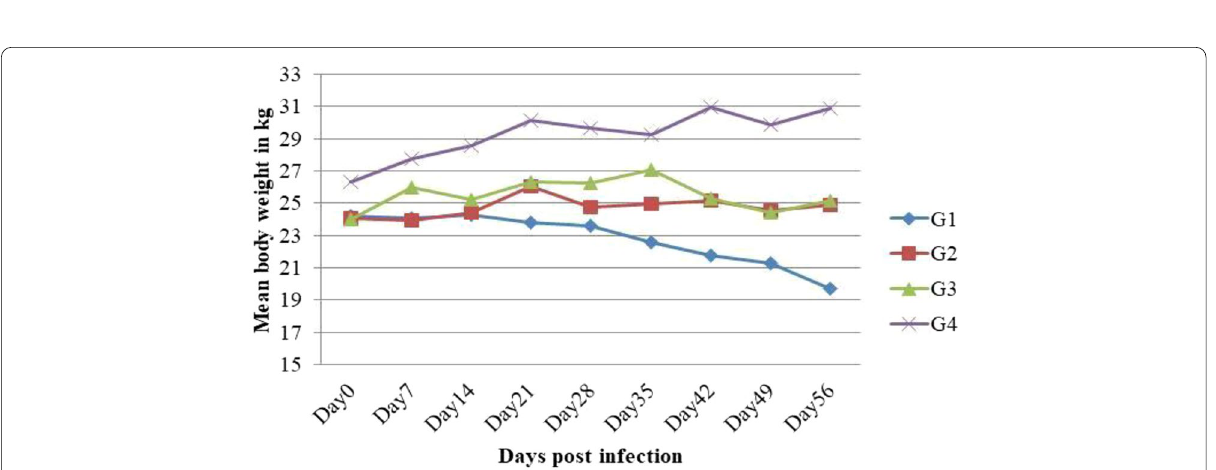
Fig. 2 Mean body weight of infected G1 and G3) and non-infected (G2 and G4)